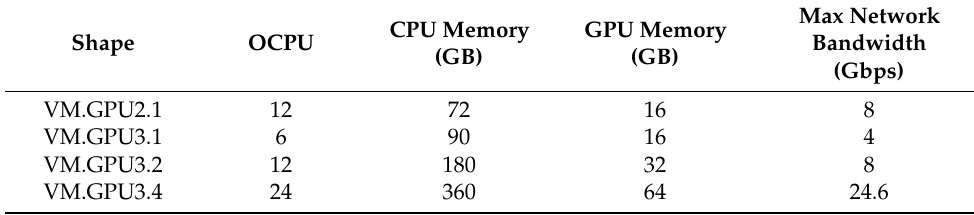
Table A3. Specifications of compute shapes in the